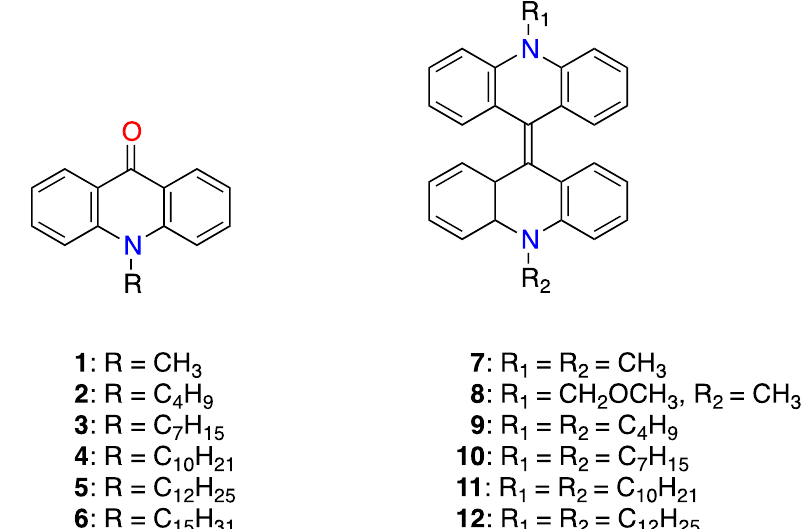
Figure 1. Chemical structures of N -alkyl-acridones 1–6 and N , N (cid:48) -dialkyl-9,9 (cid:48) -biacridylidenes 7 – 12